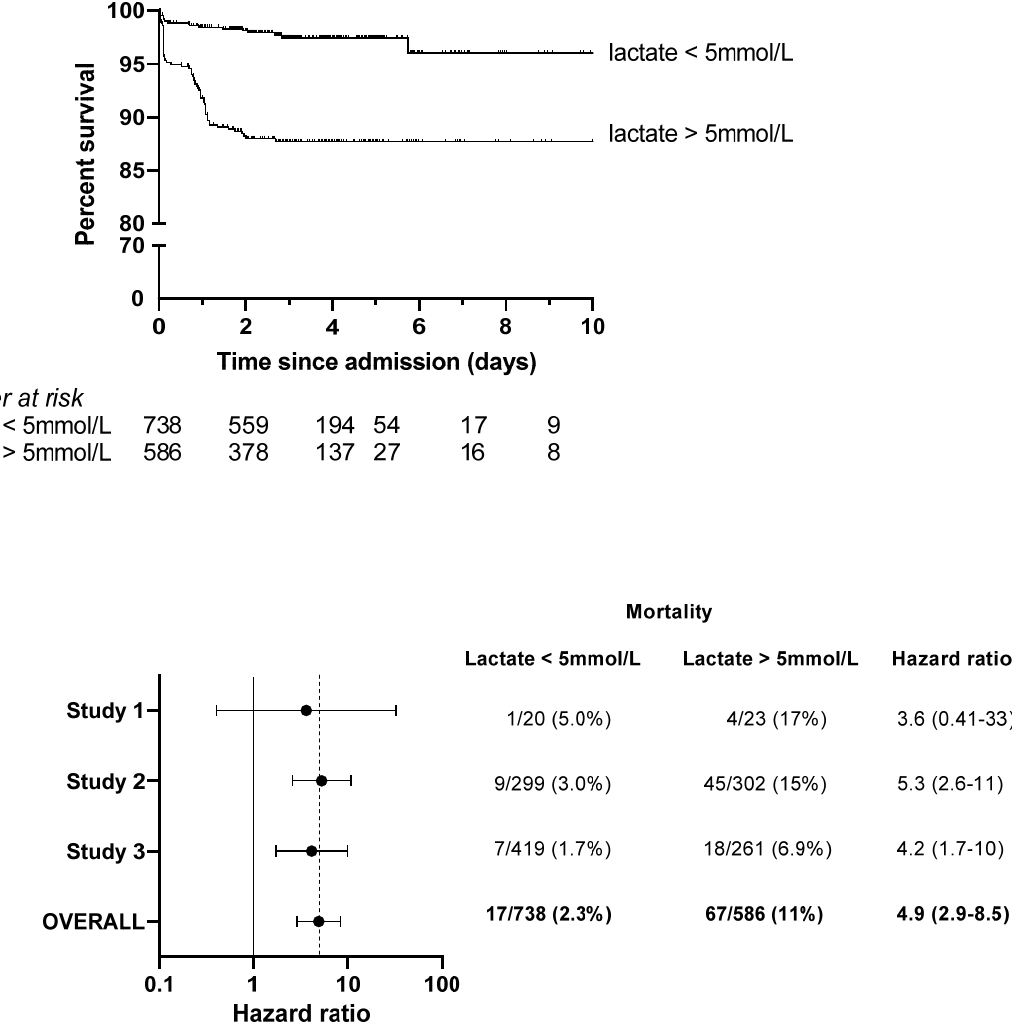
Figure 1. Point-of-care lactate measurement at admission predicts mortality in pediatric malaria patients with respiratory distress. ( A ) Kaplan–Meier curves display the survival of children stratified by presence or absence of hyperlactatemia (lactate > 5 mmol/L) at admission. Ticks denote patients that were right-censored as they were discharged from hospital, absconded, or transferred to another facility. Values at the bottom of the figure denote the number of participants remaining in each group at different timepoints. The crude hazard ratio was 5.3 (95%CI 3.1–9.0, p < 0.0001). ( B ) Hazard ratios for each primary study contributing to the pooled analysis were similar, with confidence intervals reflecting the sample size of each study. The pooled hazard ratio (random effects model) was 4.9 (95%CI 2.9–8.5, p < 0.0001).